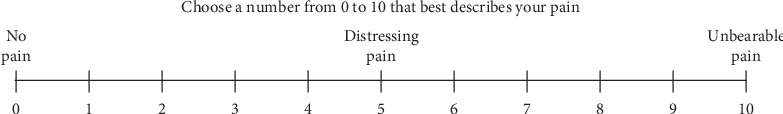
Visual analogue pain scale (VAS) for recording the pain level of patients for dry socket [30, 31].